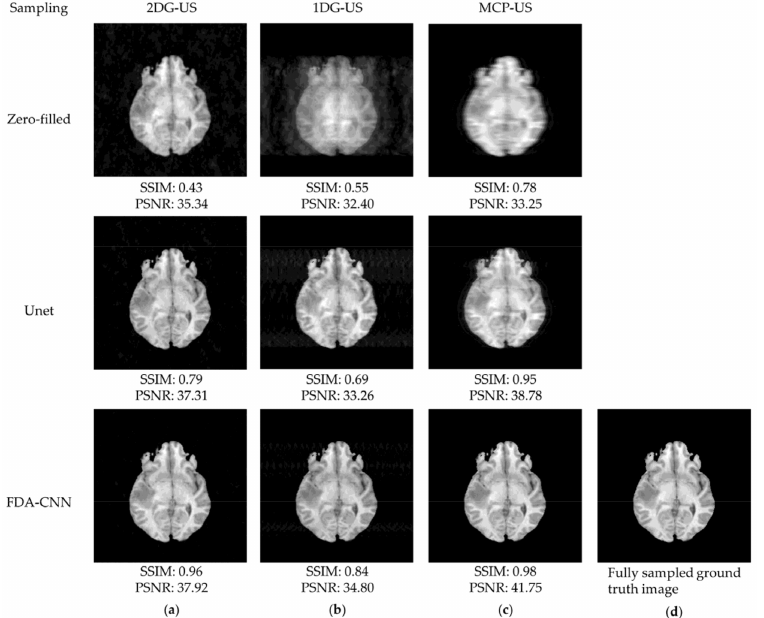
Figure 8. Reconstructed MRI images from the BraTs testing dataset (slice No. 140) using zero filling, Unet, and FDA-CNN: ( a ) 2D Gaussian distribution; ( b ) 1D Gaussian distribution; ( c ) mixed center and peripheral mask; ( d ) fully sampled ground truth image.